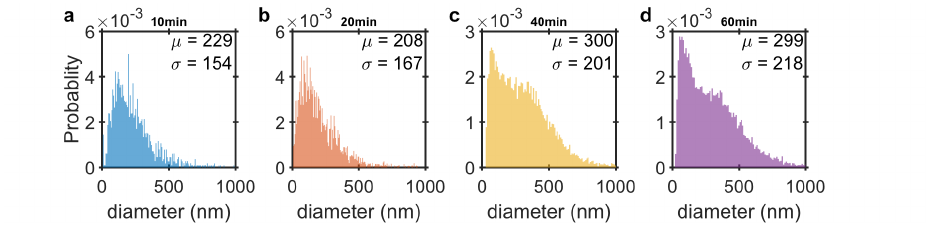
Figure 5. NTA number-weighted probability size distribution of the ( a ) 10; ( b ) 20; ( c ) 40 and ( d ) 60 min rolled RCPs labelled with fluorescent marker. The mean hydrodynamic diameter, µ , and standard deviation, σ , are obtained from fitting a normal distribution to the